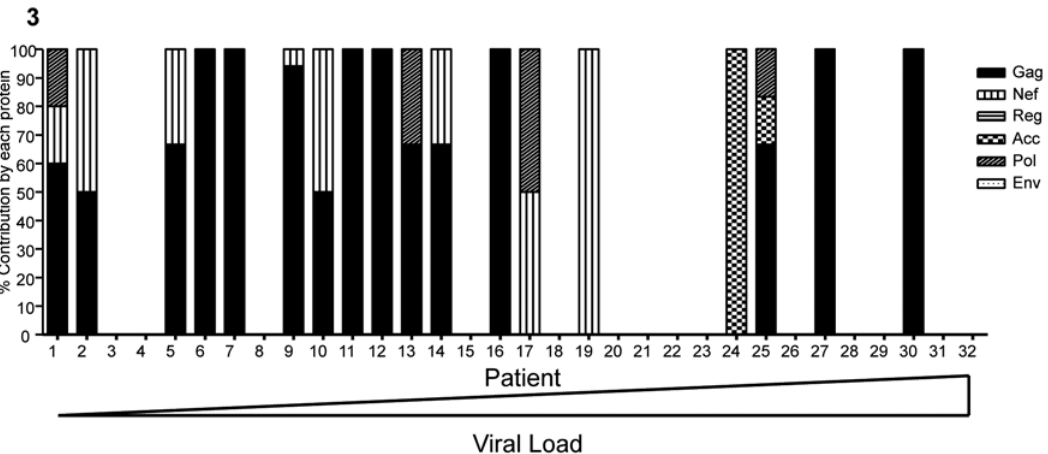
Figure 3. The total HIV-1–specific CD4 + T cell response is dominated by Gag. Using IFN- c ELISPOT assay to identify HIV-1 specific CD4 + T cell epitopes in 32 subjects, we found that irrespective of the viral load, the Gag protein is the most commonly targeted and therefore makes the greatest contribution to the overall CD4 + T cell response. Subjects 1–16 had viral loads below the median, while subjects 18–32 had viremia greater than the median (36 550 copies/ml plasma). Acc (accessory) denotes the Vpr, Vpu and Vif proteins pooled together. Subjects 24 and 25 both